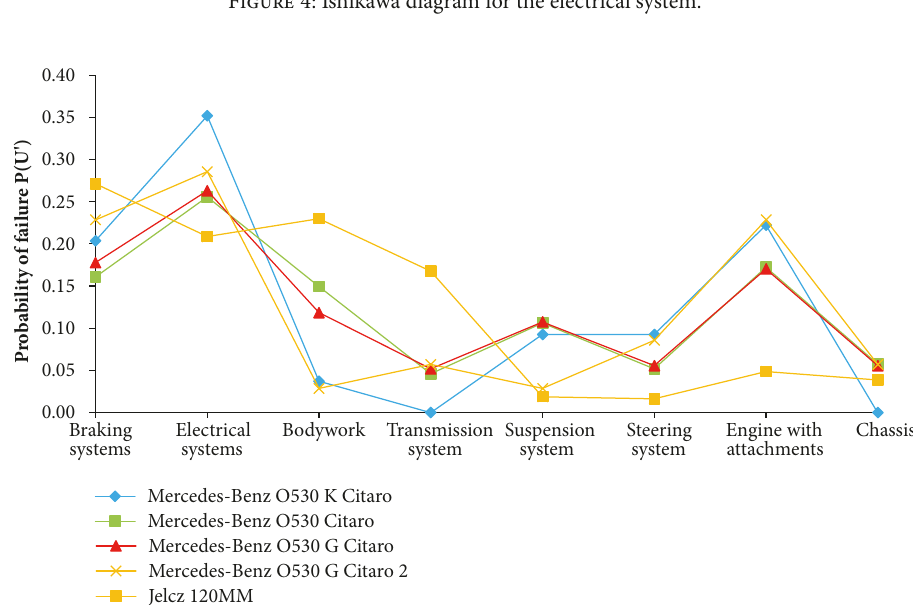
Figure 5: Values of the probability of failure for each of the bus systems in city